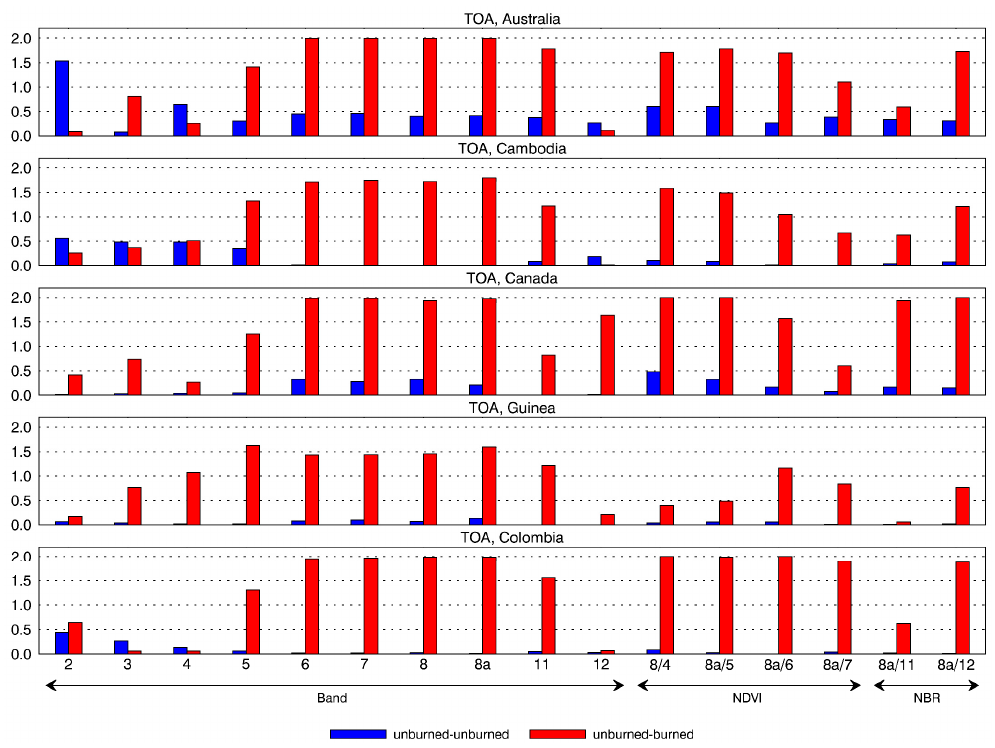
Figure 4 . Transformed divergence (TD) top of atmosphere (TOA) separability values for the ten MSI bands (Table 2) and the six spectral indices (Table 3).